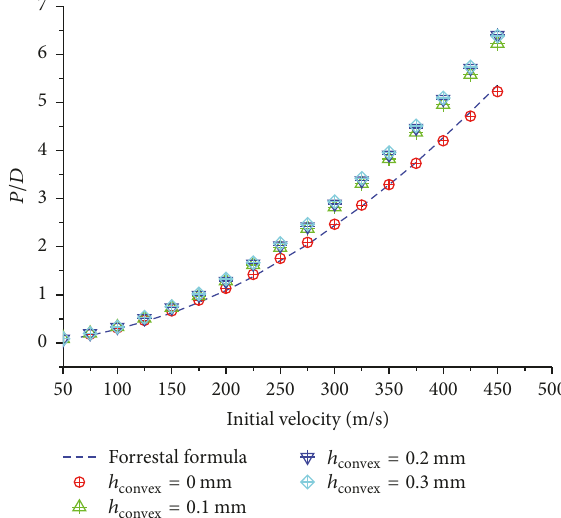
Figure 15: Ratio of penetration ( 𝑃 / 𝐷 ) with initial velocity.